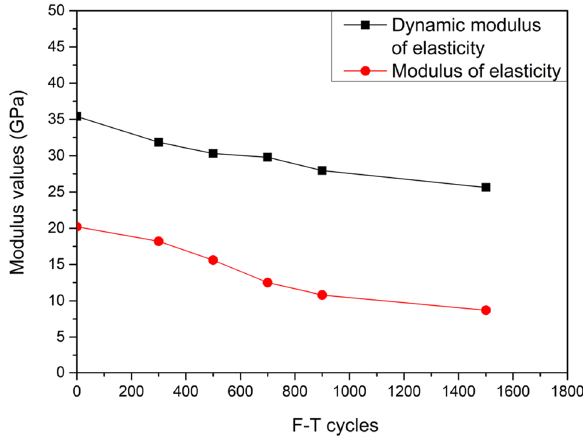
Figure 12. Modulus of concrete under F–T